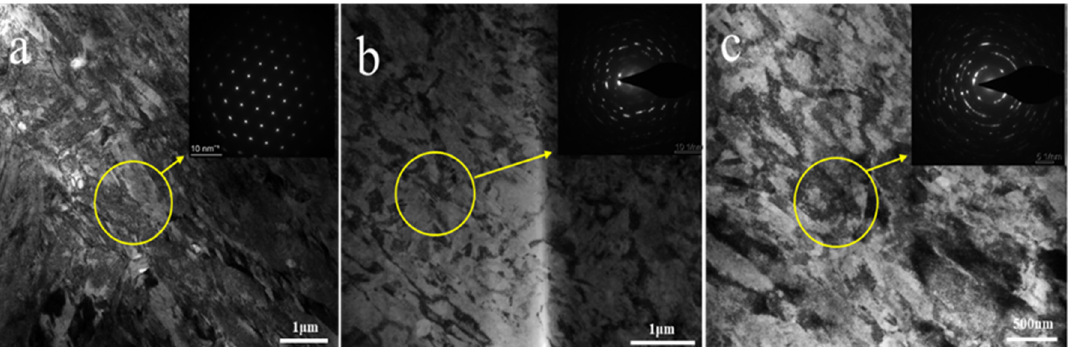
Figure 14. ( a ) TEM image of the carburized layer of C and the corresponding selected electron diffraction; ( b ) TEM image of the modified layer of C + 100P and the corresponding selected electron diffraction; ( c ) TEM image of the modified layer of C + 200P and the corresponding selected electron diffraction.